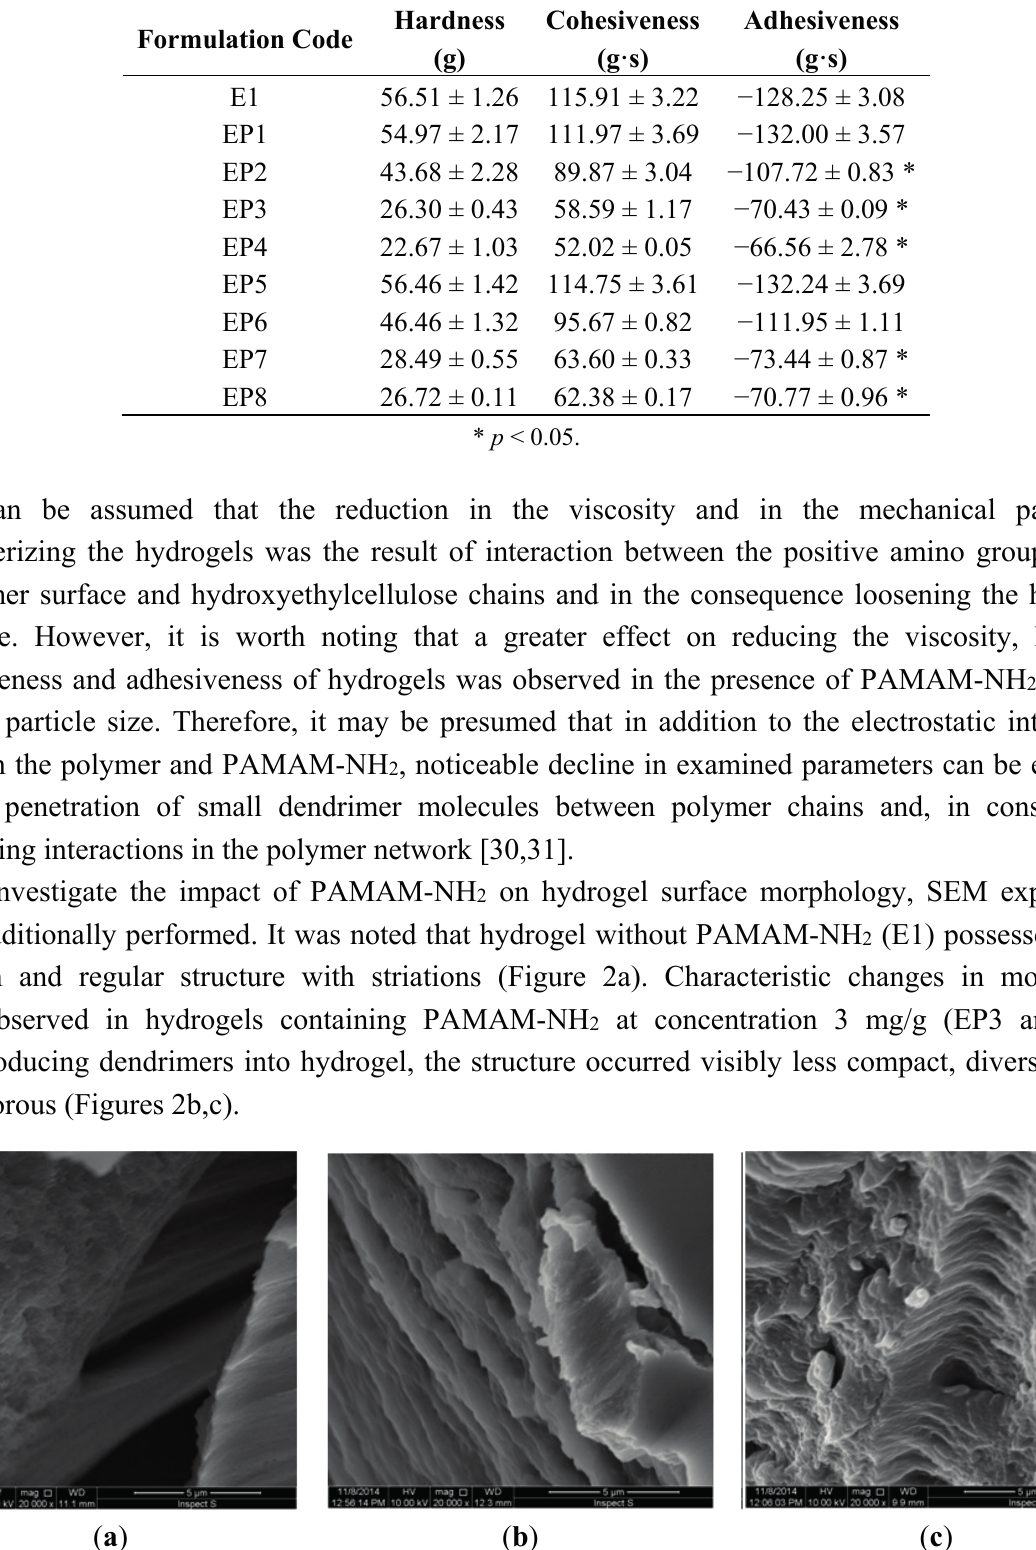
Table 3. Mechanical properties of hydrogels with different concentrations of PAMAM-NH 2 G2 or G3.